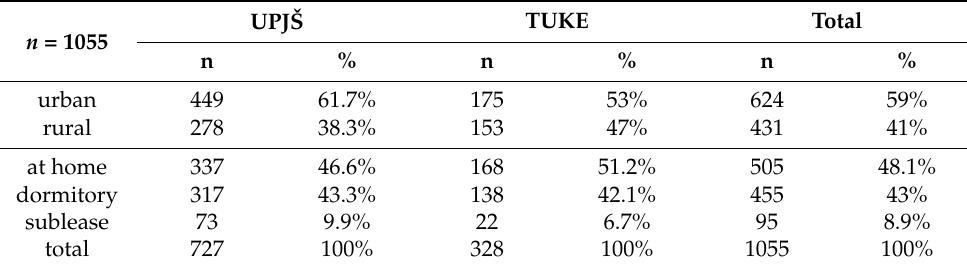
Table 2. Place of permanent residence and current residence of respondents. n =